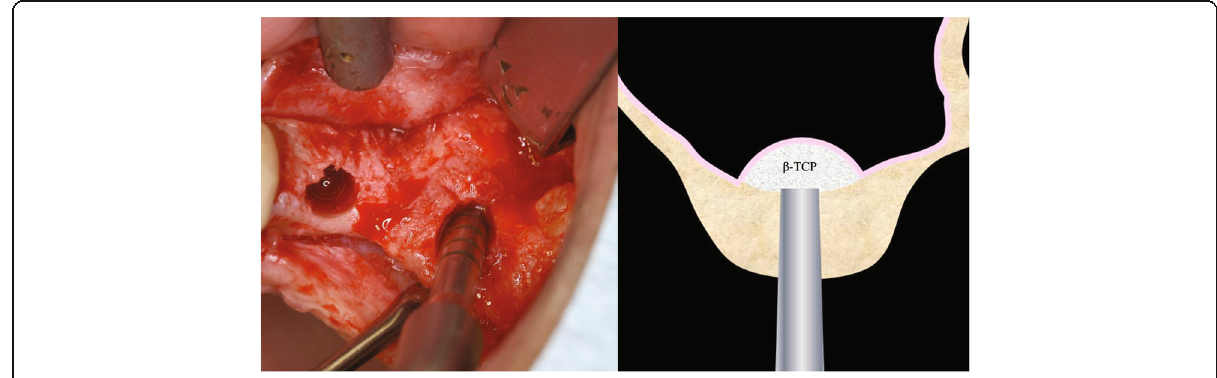
Fig. 2 Maxillary sinus floor augmentation using the crestal approach followed by bone-added sinus floor elevation